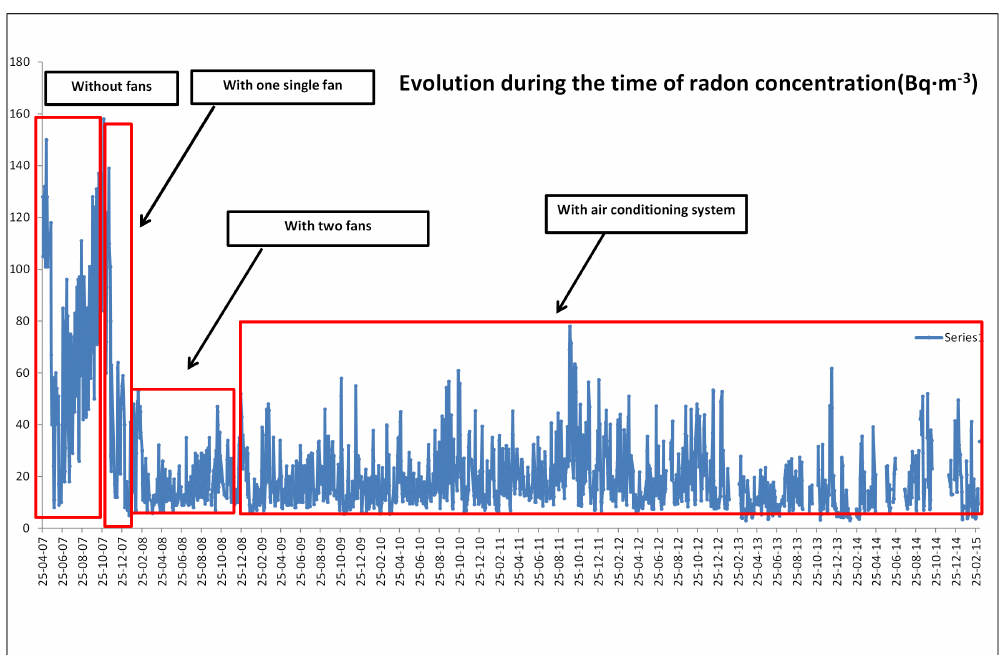
Figure 6. Evolution of radon gas measurement with the different